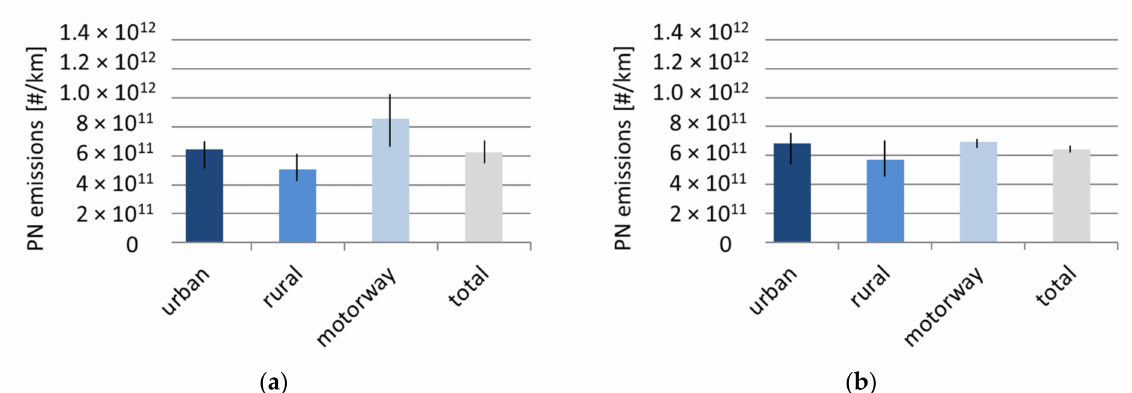
Figure 6. Influence of driving mode on the real-world particulate number (PN) emissions of the studied PHEV during summer time. ( a ) Hybrid driving mode; ( b ) Sport driving